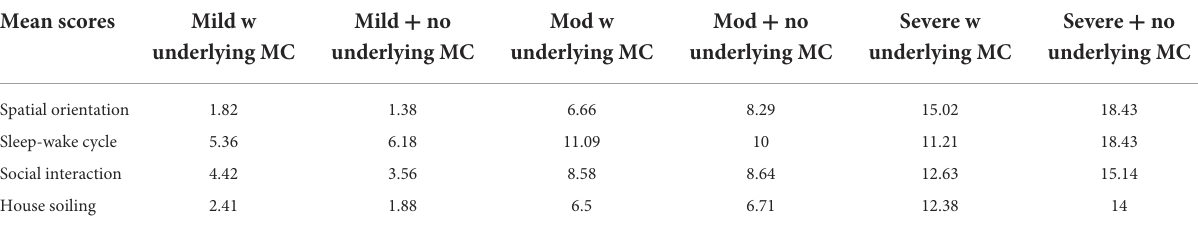
TABLE 3 Mean scores for each CADES category among all presumptive CI groups.